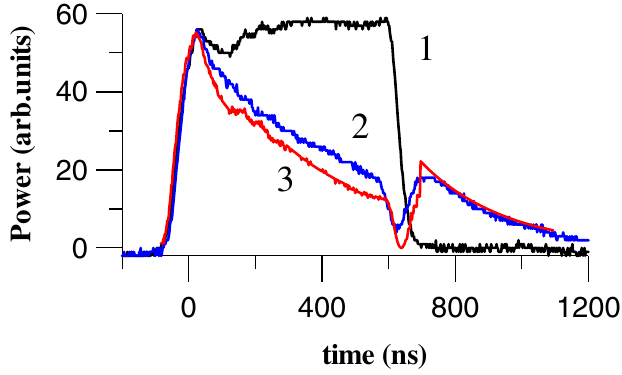
FIG. 8. (Color) Traces from the output of the QO compressor show the nonresonant case (1—experiment) and a resonant case (2—experiment, 3—calculation for resonator parameters: Q 5 : 4 (cid:4) 10 4 , (cid:7) ¼ 0 : 65 ).